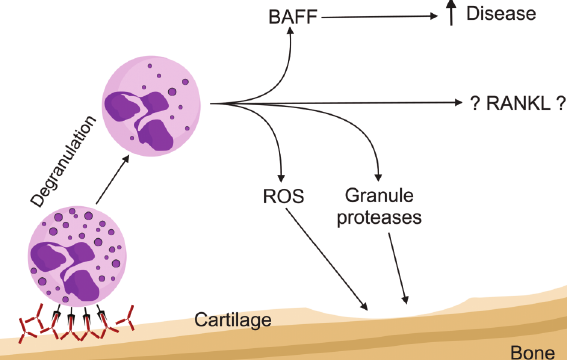
Figure 3. Neutrophils in autoimmune disease with rheumatoid arthritis as an example. Immunocomplexes activate neutrophils, which in turn release proteases damaging the cartilage. Induction of oxidative bursts generates reactive oxygen species (ROS), which also directly damage the articular cartilage. In addition, B-cell activating factor (BAFF) secretion activates B cells. Receptor activator of nuclear factor kappa-B ligand (RANKL) production by neutrophils has been shown in mature peripheral neutrophils. In bone, preliminary data indicate that RANKL derived from neutrophils in the bone marrow might participate in bone